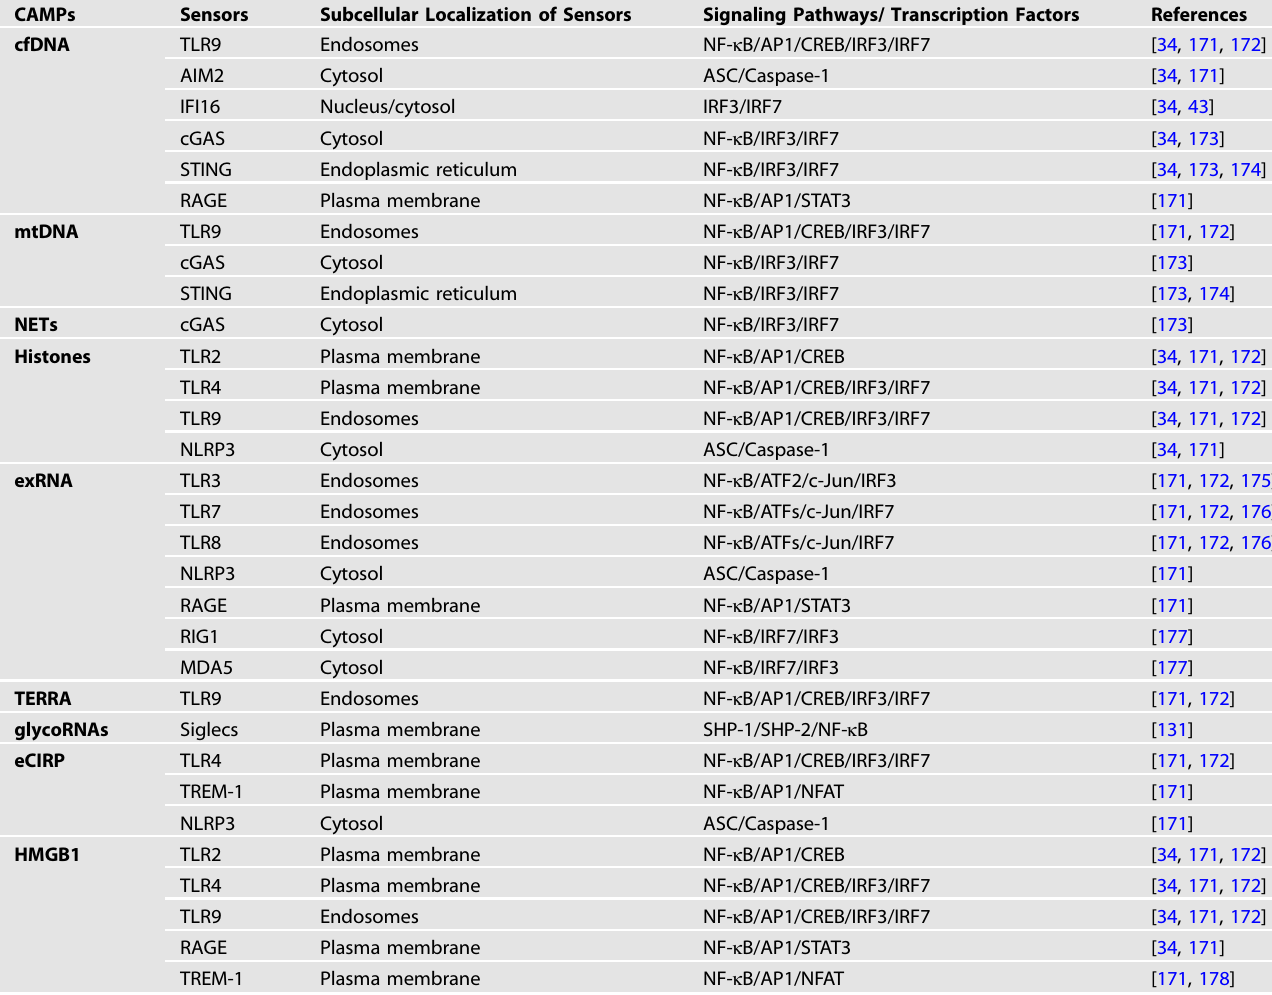
Table 2. CAMPs Signal Transduction Pathways.